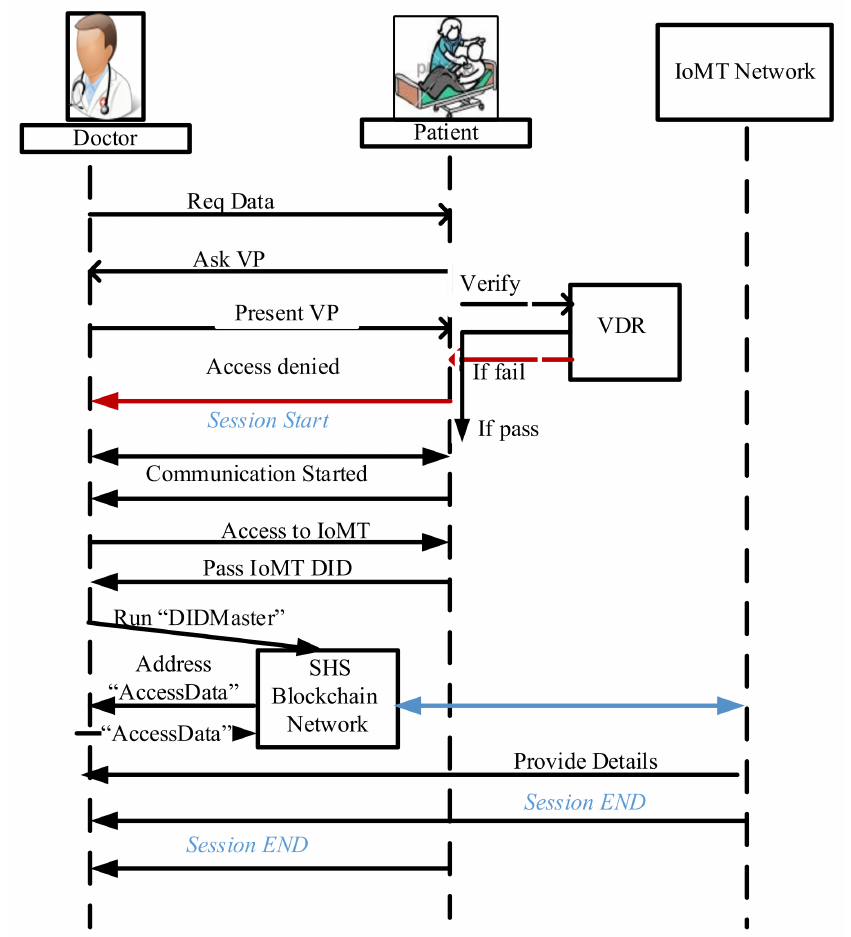
Figure 5. SSI-SHS process flow scenario: The doctor access the IoMT